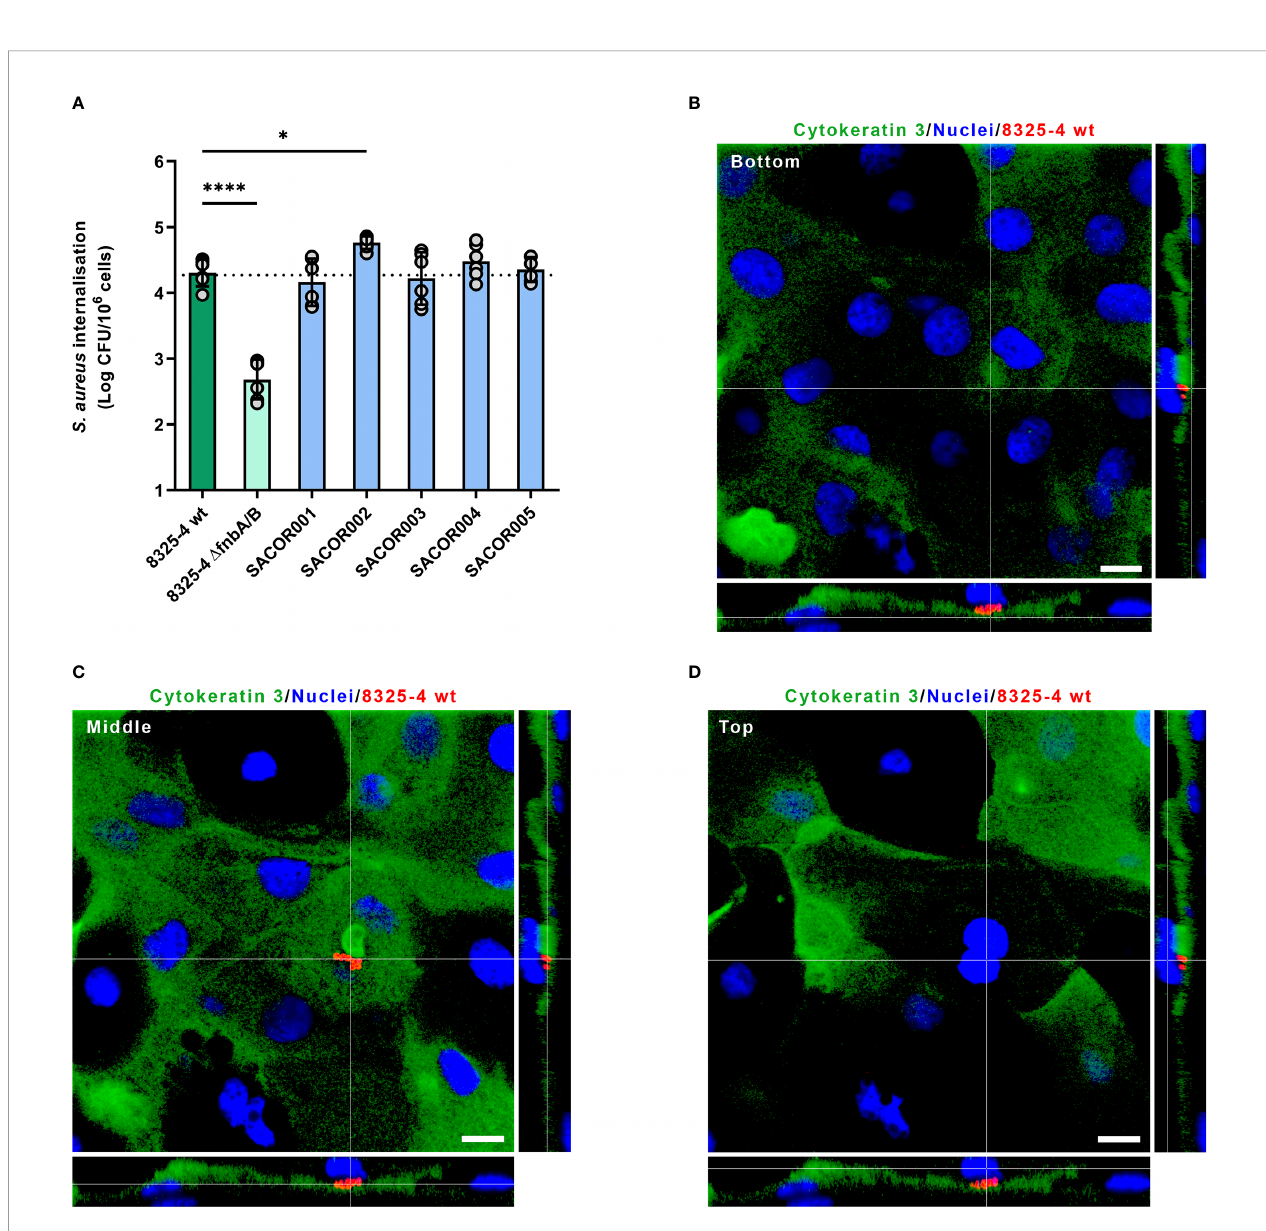
FIGURE 2 | Staphylococcus aureus internalization inside corneal epithelial cells and human cornea. (A) Invasion of HCE-2 corneal epithelial cells by S. aureus clinical isolates recovered from patients with keratitis. Dotted line corresponds to the mean of intracellular load of S. aureus 8325-4 wild type (wt). (B – D) Confocal laser scanning microscopy of human cornea infected with S. aureus 8325-4. S. aureus cells (red) were located inside corneal epithelial cells (cytokeratin 3 immunolabeled in green, nuclei stained in blue). Orthogonal views correspond to a slice below S. aureus cluster ( B ; bottom), a slice within S. aureus cluster ( C ; middle), and a slice above S. aureus cluster ( D ; top).